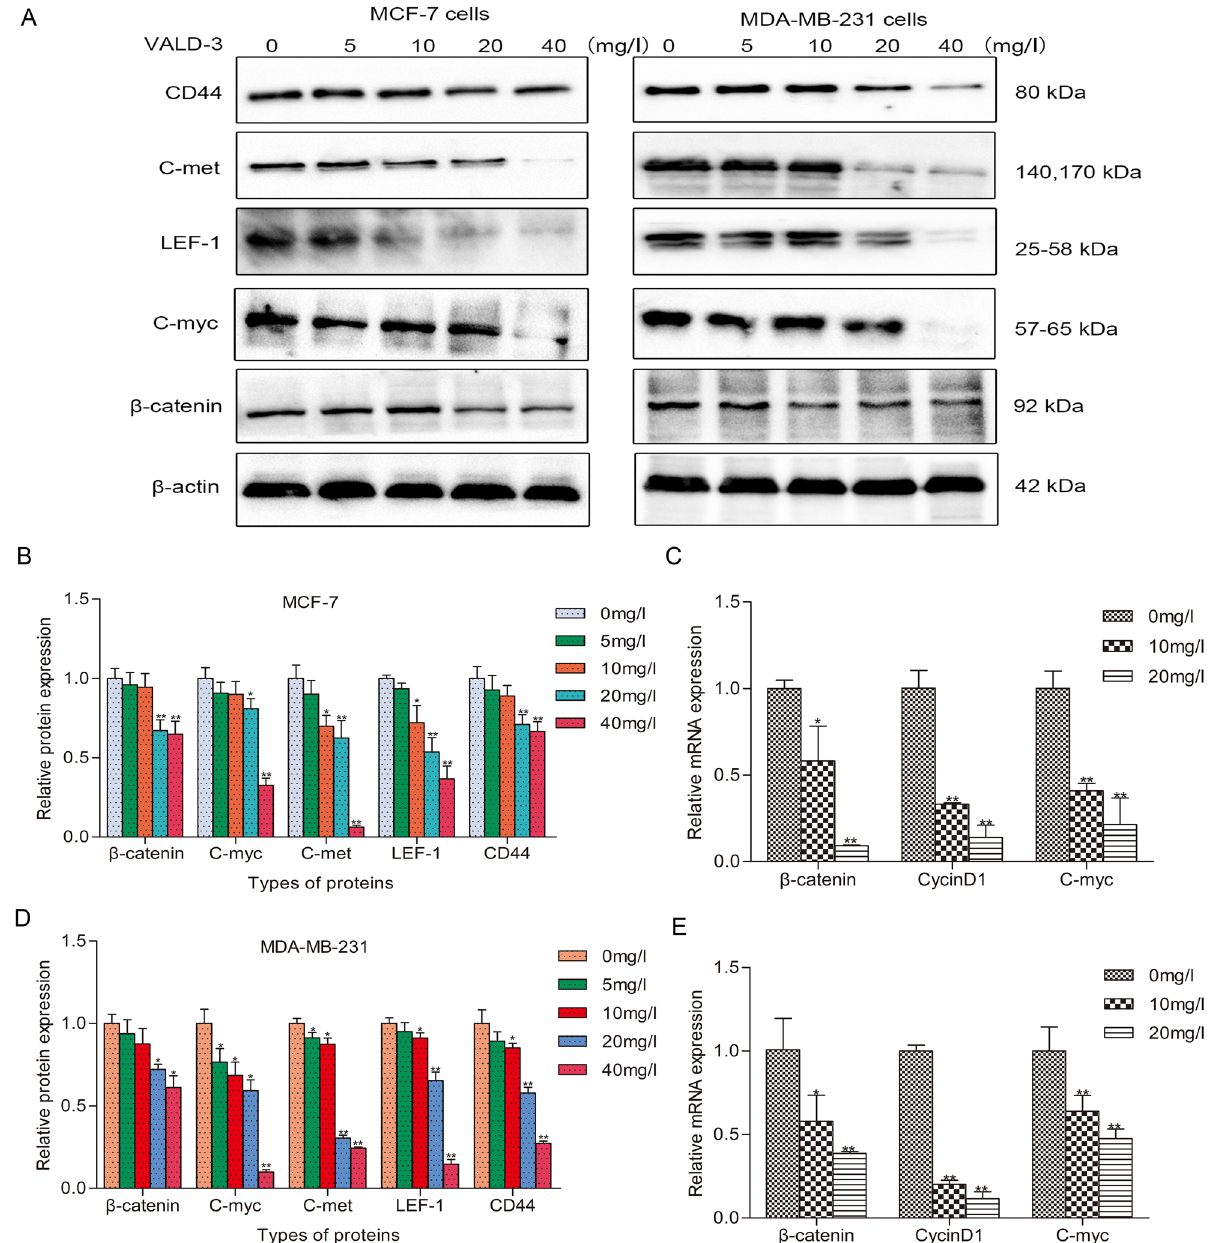
Figure 6. Effects of VALD-3 on the levels of Wnt/β-catenin pathway and its downstream molecules in MCF-7 cells and MDA-MB-231 cells. ( A ) MCF-7cells and MDA-MB-231cells were treated with the indicated concentrations of VALD-3 for 48 h, and levels of β-catenin, c-myc, LEF-1, c-met and CD44 in VALD-3-treated breast cancer cells were detected by Western blotting. ( B ) The relative levels of β-catenin, c-myc, LEF-1, c-met and CD44 in MCF-7 cells were analyzed. ( C ) The mRNA expression levels of β-catenin, c-myc and cyclinD1 in MCF-7 cells were analyzed by qRT-PCR. ( D ) The relative levels of β-catenin, c-myc, LEF-1, c-met and CD44 in MDA-MB-231 cells were analyzed. ( E ) The mRNA expression levels of β-catenin, c-myc and cyclinD1 in MDA-MB-231 cells were analyzed by qRT-PCR. * P < 0.05, ** P < 0.01 compared with the control group. All data are presented as the mean ± SD from three independent